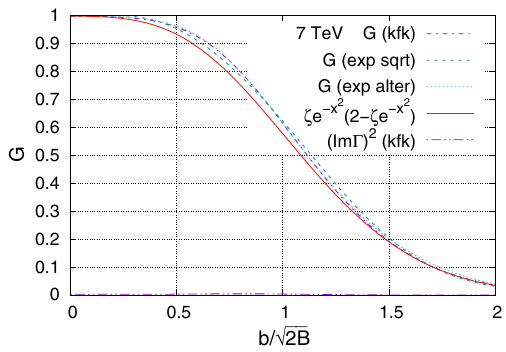
Fig. 2 The same as Fig. 1 but at 13 TeV and with ζ = 0 . 96906